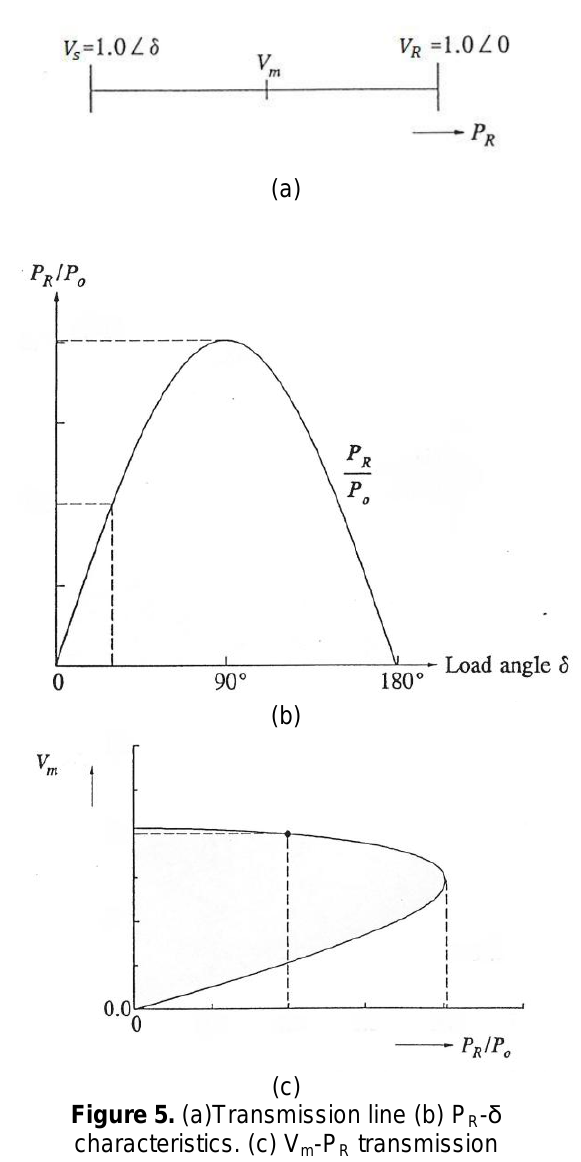
-P transmission m R